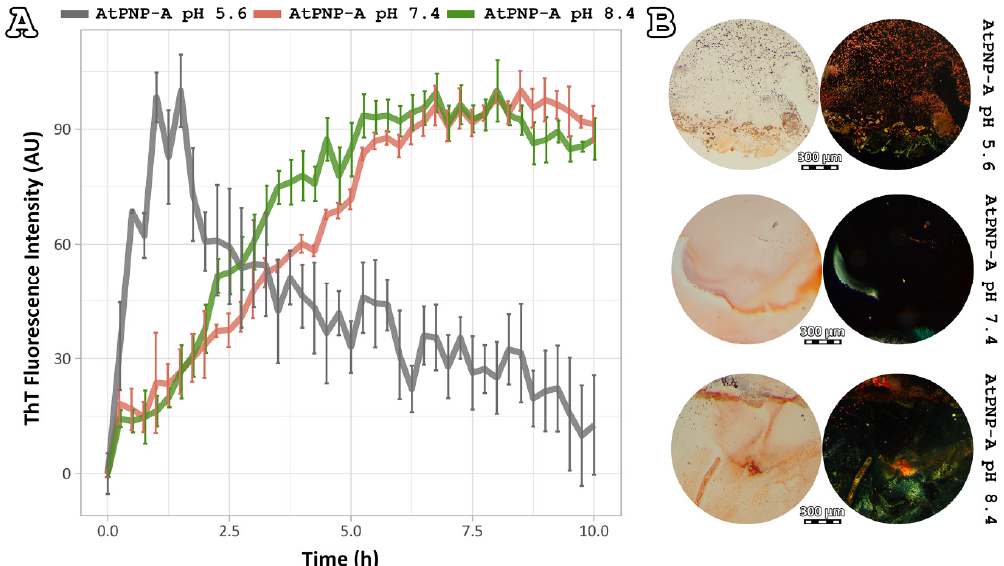
Figure 4. ThT and Congo Red assays of AtPNP-A 36–69 amyloid-like fibrils. ( A ) ThT fluorescence emission spectrum of AtPNP-A 36–69 incubated in three different pH conditions over a period of 10 h. AtPNP-A 36–69 , when dissolved in pH 7.4 (HEPES buffer) and 8.4 (Tris buffer), reached its peak after approximately 5 h (red and green line, respectively). When AtPNP-A 36–69 is incubated in pH 5.6 (MES buffer), reached the highest value after approximately 1 h. Error bars in ThT fluorescence emission spectra represent standard deviation among triplicates. ( B ) Congo red staining results from the AtPNP-A 36–69 fibrils. Photomicrographs of the fibrils (Left) under bright field illumination and (Right) under crossed polars. The typical for amyloid fibrils yellow/green birefringence clearly appears under crossed polars (Right). Bar 300µm.